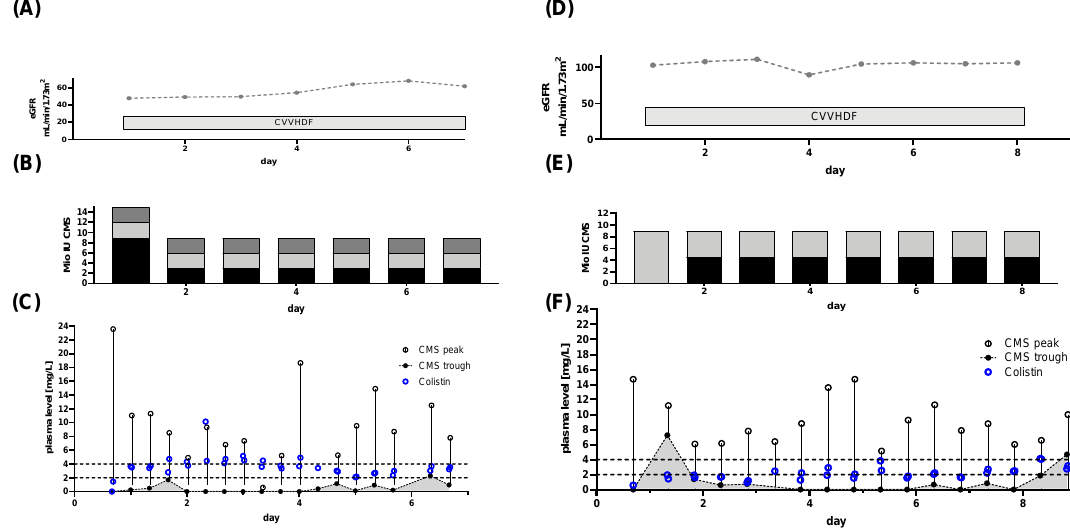
Figure 9. Renal function, dose regimen and drug plasma levels of patient 7 First treatment cycle ( A – C )a total of 35 samples were analyzed (CMS peak n = 17, CMS trough n = 18, Colistin peak n = 17, Colistin trough n = 17). During the 2nd treatment cycle ( D – F ) a total of 32 samples, CMS peak n = 17, CMS trough n = 16, Colistin peak n = 17, Colistin trough n = 15) were analyzed. ( A ) / ( D ) estimated glomerular filtration rate (eGFR) derived from serum creatinine levels and renal replacement therapy (RRT) via continuous venovenous hemodiafiltration (CVVHDF). ( B ) / ( E ) Dose regimen used. Shaded blocks depict the particular individual doses each day. ( C ) / ( F ) Time course of CMS trough and peak levels along with Colistin levels. The CMS reservoir is indicated by the area gray shaded portion of panel ( C ) / ( F ). Target range for Colistin plasma levels is indicated by dashed lines.